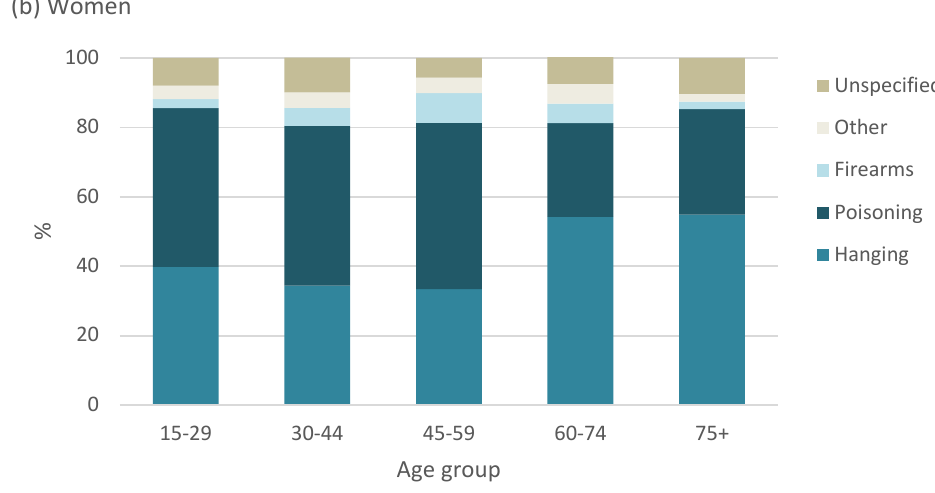
Figure 7. Distribution of suicides by method for broad age groups for men and women, South Africa, 1997–2016. ( a ) Men; ( b ) Women.